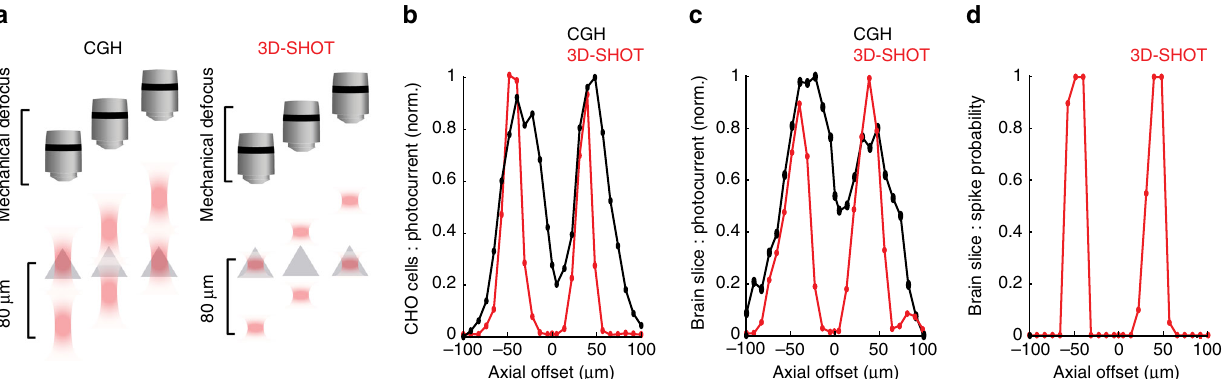
Fig. 6 Single-neuron resolution with simultaneous photostimulation of two targets along the axial dimension. a Using CGH or 3D-SHOT we simultaneously photostimulated two targets separated by 80 µ m along the optical z- axis. The photocurrent was recorded as a function of the respective displacement Δ z between one patched cell and the volume hologram in an example CHO cell ( b , n = 11 cells) or in an example cortical neuron ( c , n = 5 neurons), with conventional holography (black) and with 3D-SHOT (red). d As in c , but recording spike probability instead of photocurrent for